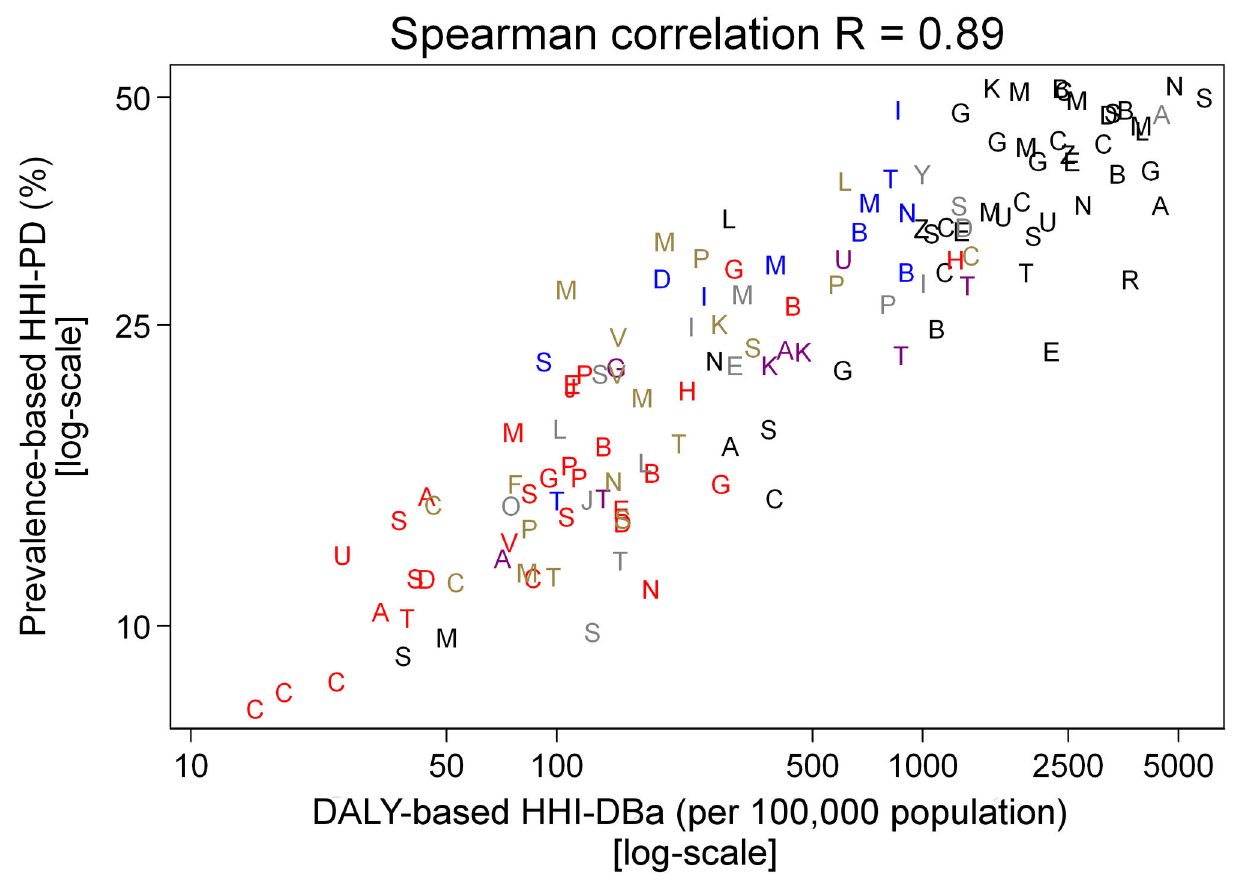
Figure 6. The association between hidden hunger index based on the prevalence estimates (HHI-PD) and hidden hunger associated Disability Adjusted Life Years (DALY) (HHI-DBa) in 133 countries. Prevalence-based HHI-PD estimates were not available for three of the 136 countries with HHI-DBa estimates (the Bahamas, Bahrain, and